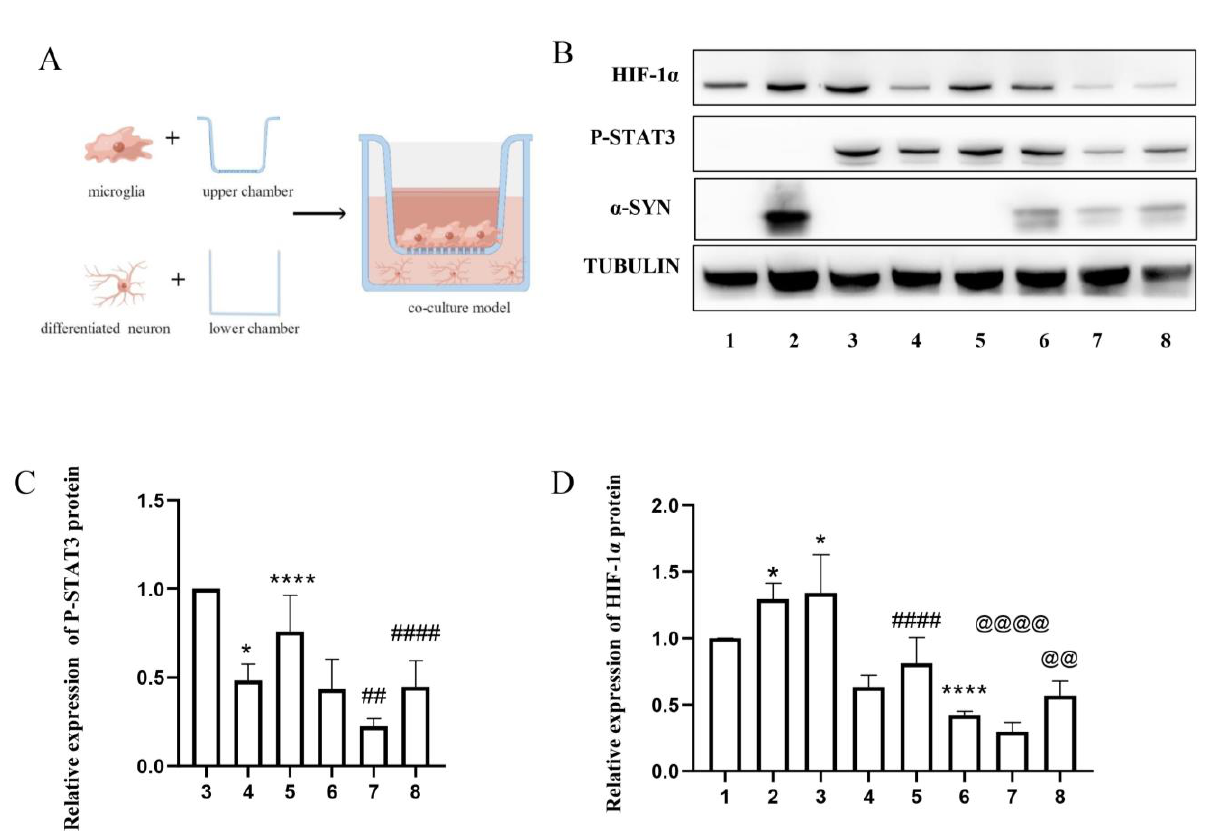
Figure 4. Over-expression of IL6ST-AS in microglia had an effect on the STAT3-HIF-1 α axis restraint in neurons. SH-SY5Y cells were divided into eight groups: 1. only SH-SY5H cells, 2. α -synuclein-induced (25 µ mol/L) SH-SY5H cells, 3. SH-SY5H cells co-cultured with HMC3 cells, 4. SH-SY5H cells co-cultured with IL6ST-AS UP HMC3 cells, 5. SH-SY5H cells co-cultured with IL6ST-AS KO HMC3 cells, 6. SH-SY5H cells co-cultured with α -synuclein-induced (25 µ mol/L) HMC3 cells. 7. SH-SY5H cells co-cultured with α -synuclein-induced (25 µ mol/L) IL6ST-AS UP HMC3 cells, and 8. SH-SY5H cells co-cultured with α -synuclein-induced (25 µ mol/L) IL6ST-AS KO HMC3 cells. ( A ) Schema of HMC3 cells and SH-SY5H cells co-culture. ( B ) The expression of P-STAT3 and HIF-1 α in SH-SY5H cells was detected by Western blot. ( C ) Quantitative data of P-STAT3 Western blots in different groups. ( D ) Quantitative data of HIF-1 α Western blots in different groups. Data = mean ± SD, * indicates p < 0.05, **** indicates p < 0.0001, @@ or ## indicates p < 0.01, #### or @@@@ indicates p <